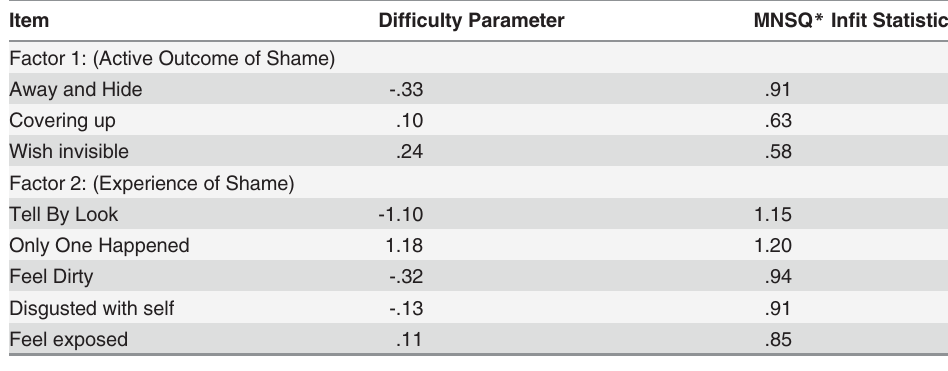
Table 4. Multidimensional Rating Scale Model with Unstandardized